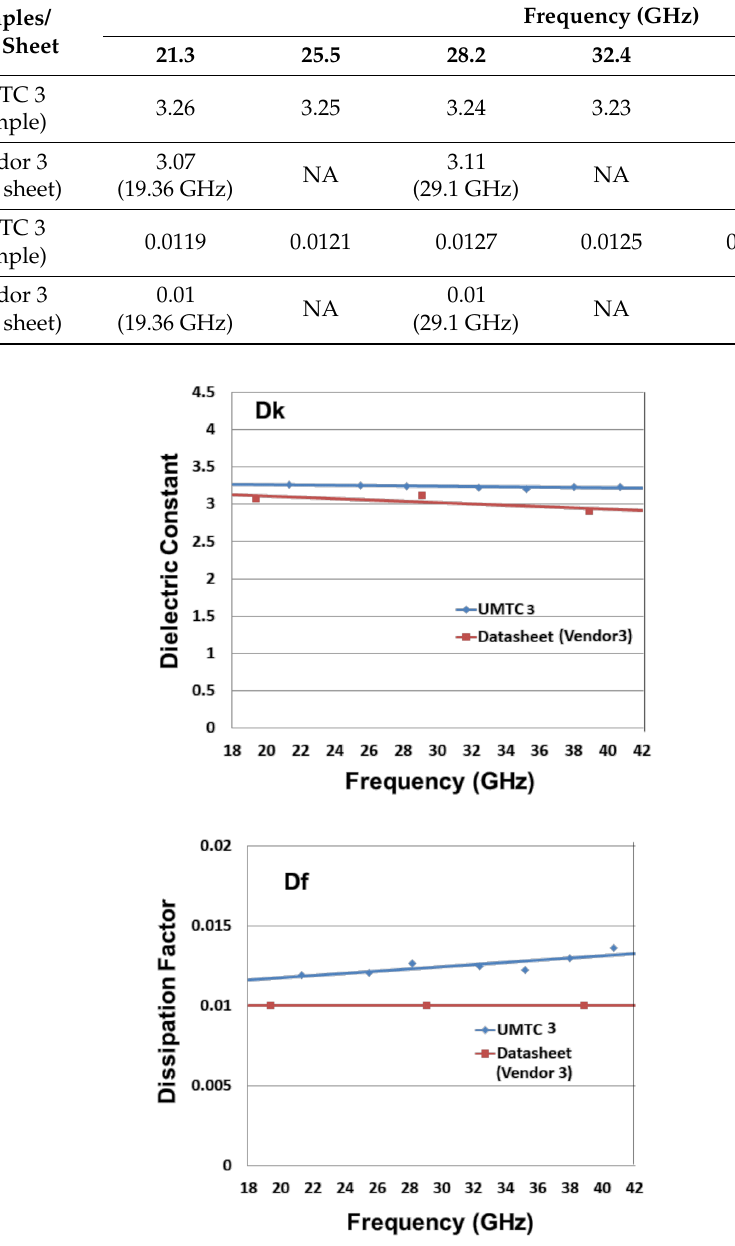
Figure 8. Dk and Df of Vendor